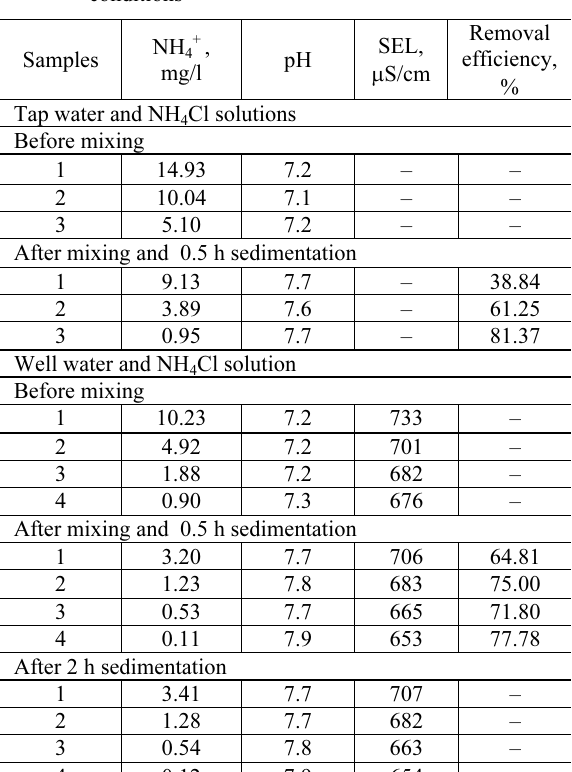
Table 3. Results of NH + 4 removals from water under